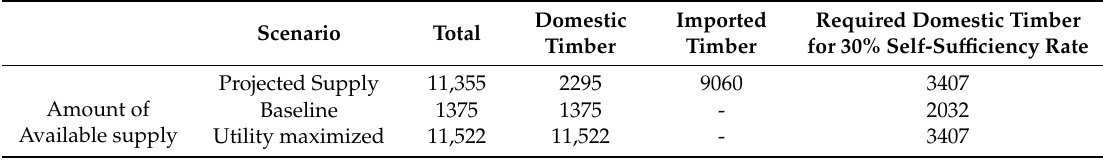
Table 9. Projected timber demand and amount of available supply by scenarios.